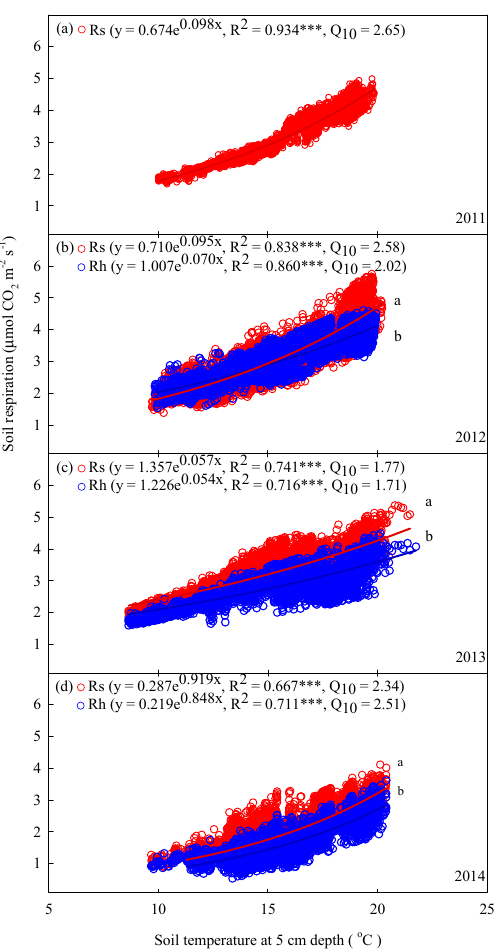
Figure 4. Relationships between half-hourly mean soil respiration (Rs, μ mol CO 2 m − 2 s − 1 ), heterotrophic respiration (Rh), and hourly soil temperature at 5 cm depth (°C) in ( a ) 2011, ( b ) 2012, ( c ) 2013, and ( d ) 2014. Asterisks indicate a significance: *** p < 0.001. Different letters indicate differences between regression lines within the same year at p < 0.05.